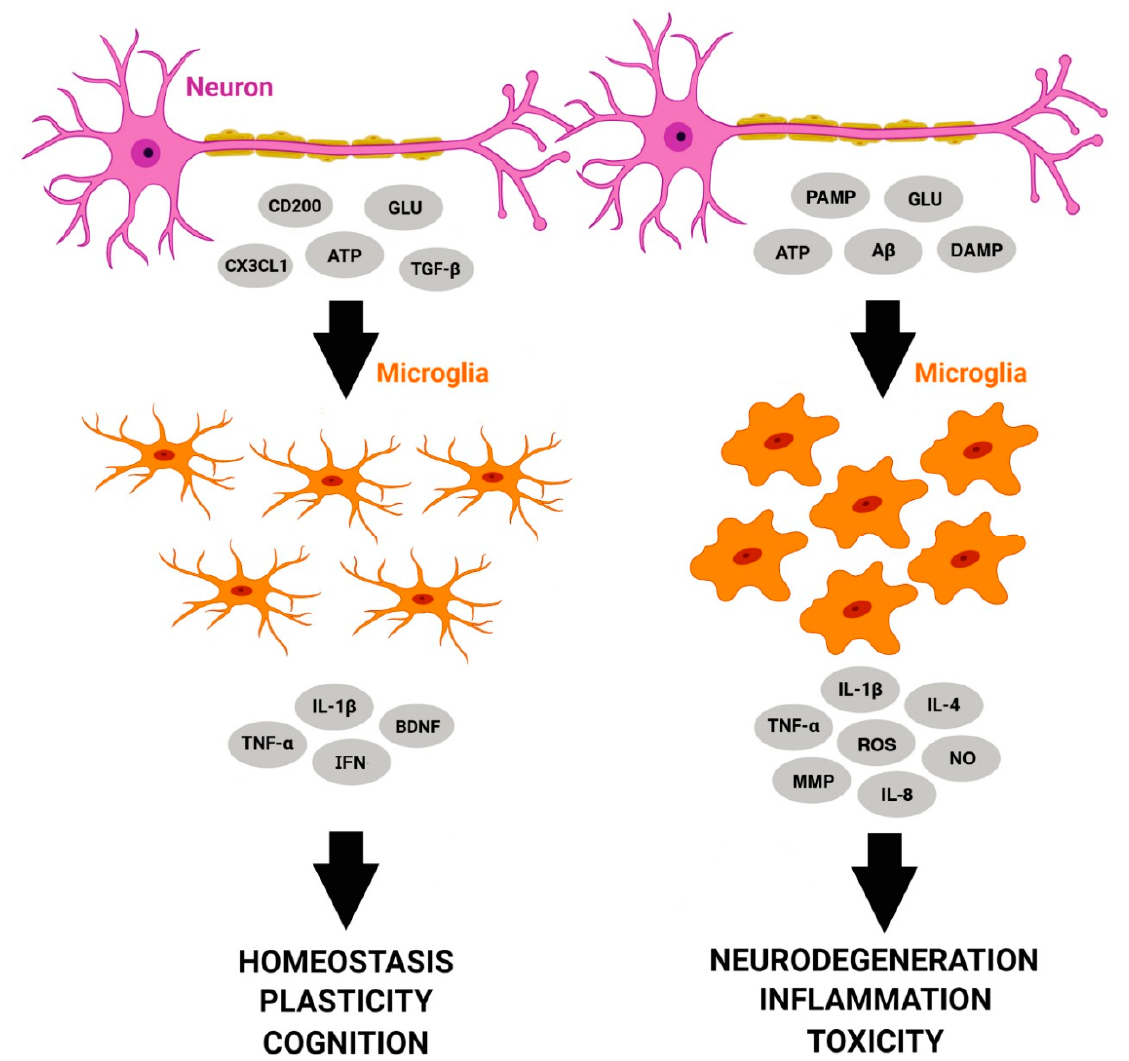
Figure 1. Microglial responses to di ff erent molecules released by neurons . CX3CL1, CD200, glutamate, ATP, and TGF- β induce an anti-inflammatory microglial profile, with microglia performing housekeeping tasks and contributing to homeostasis, plasticity, and cognition processes through release of TNF- α , IL-1 β , IFN, and BDNF. In a di ff erent scenario, ATP, glutamate, danger-associated molecular patterns (DAMPs), pathogen-associated molecular patterns (PAMPs), and amyloid-beta proteins drive microglial behavior to a more responsive pro-inflammatory state, releasing IL-1 β , TNF- α , IFN- γ , IL-4, ROS, NO, IL-8, and MMP. When the pro-inflammatory profile is maintained for a long time, it foments pathological conditions, such as toxicity, neuroinflammation, and neurodegeneration.